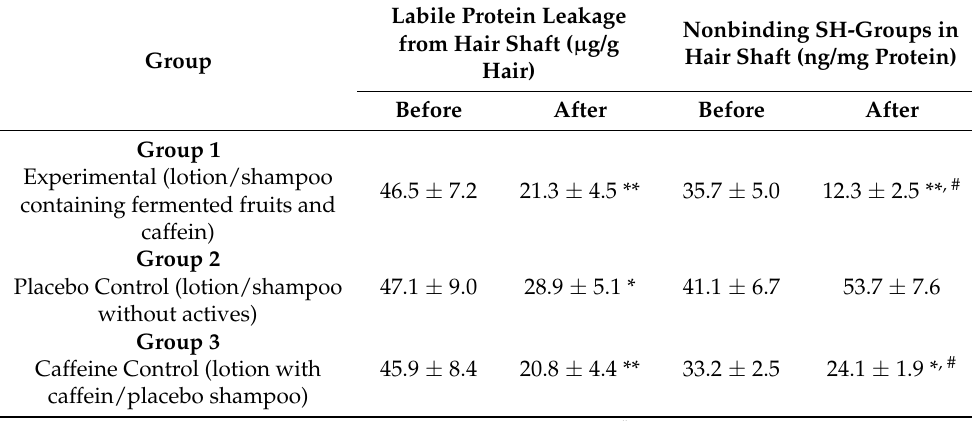
Figure 10. Relationship between ATP content in hair follicles and labile protein leakage from the hair shaft in patients with two types of alopecia ( n = 154). Blue dots represent values for the individual person. Red line is a correlation curve. Table 6. Dynamics of labile protein leakage ( µ g/g) from the hair shaft and non-binding SH-groups (ng/mg protein) in the hair